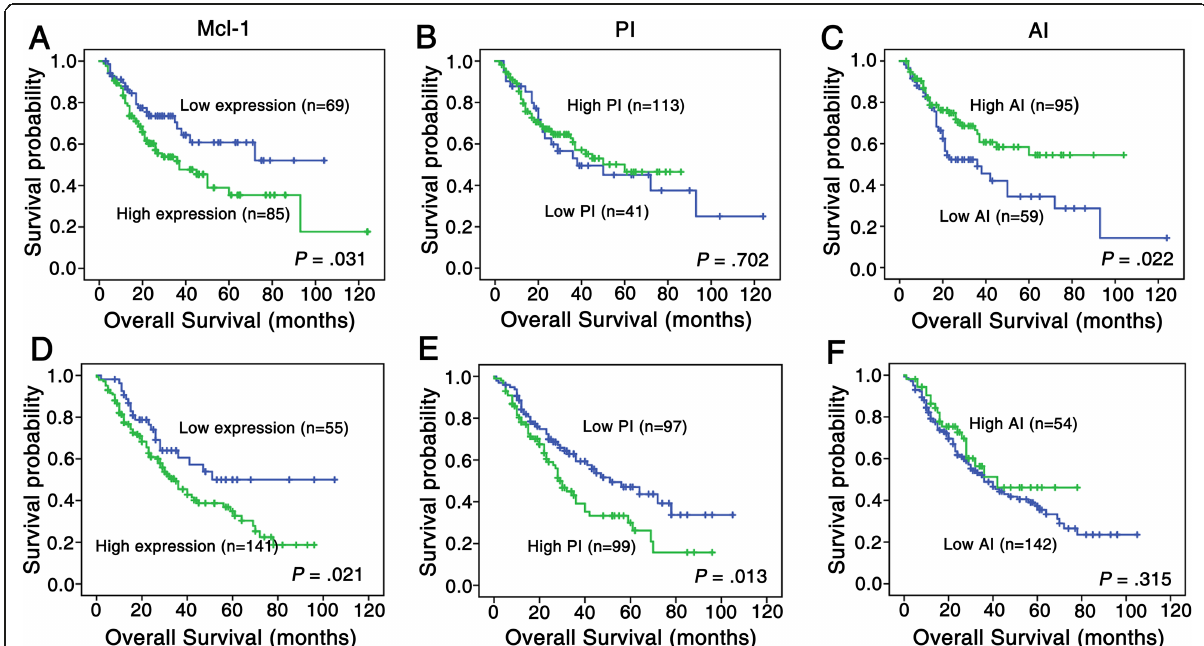
Fig. 4 Kaplan-Meier cures for overall survival of lung SCC and lung ADC patients with Mcl-1 expression, PI and AI. Kaplan-Meier analysis was used to plot the overall survival of 154 cases of lung SCC ( a - c ) and 196 cases of lung ADC ( d - f ) patients with differential Mcl-1 expression, PI and AI, which statistical significance was assessed by log-rank test. ( a ) Lung SCC patients with high Mcl-1 expression showed worse overall survival rates compared to patients with low Mcl-1 expression ( P = 0.031, two sided). ( b ) PI had no significantly correlation with overall survival rates of lung SCC patients ( P > 0.05, two sided). ( c ) Lung SCC patients with high AI showed better overall survival rates compared to those with low AI ( P = 0.022, two sided). ( d ) Lung ADC patients with high Mcl-1 expression had worse overall survival rates than that with low Mcl-1 expression ( P = 0.021, two sided). ( e ) Lung ADC patients with high PI showed worse overall survival rates than those with low PI ( P = 0.013, two sided). ( f ) The AI had no significantly correlation with overall survival rates of lung ADC patients ( P > 0.05, two